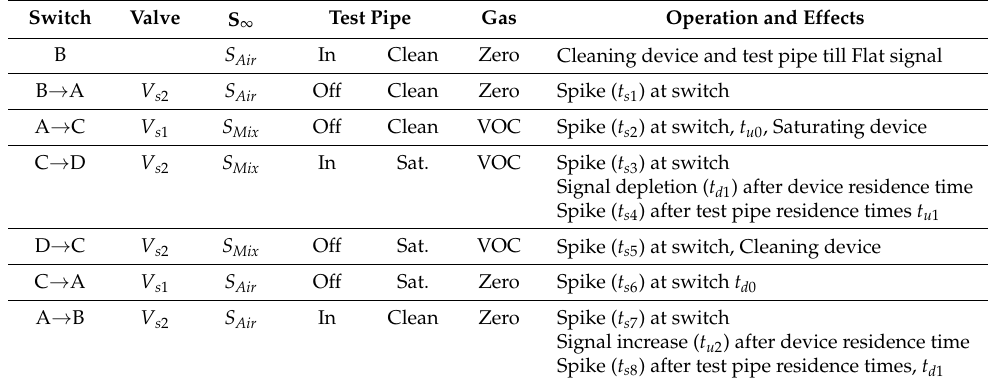
Table 1. Sequence of configurations on measurement.